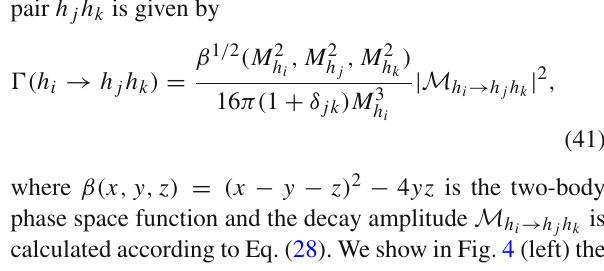
Fig. 3 Effective Higgs self-coupling ˆ λ eff mass eigenstate for P2OS as a function of ϕ A Color and line codes are the same as in Fig.